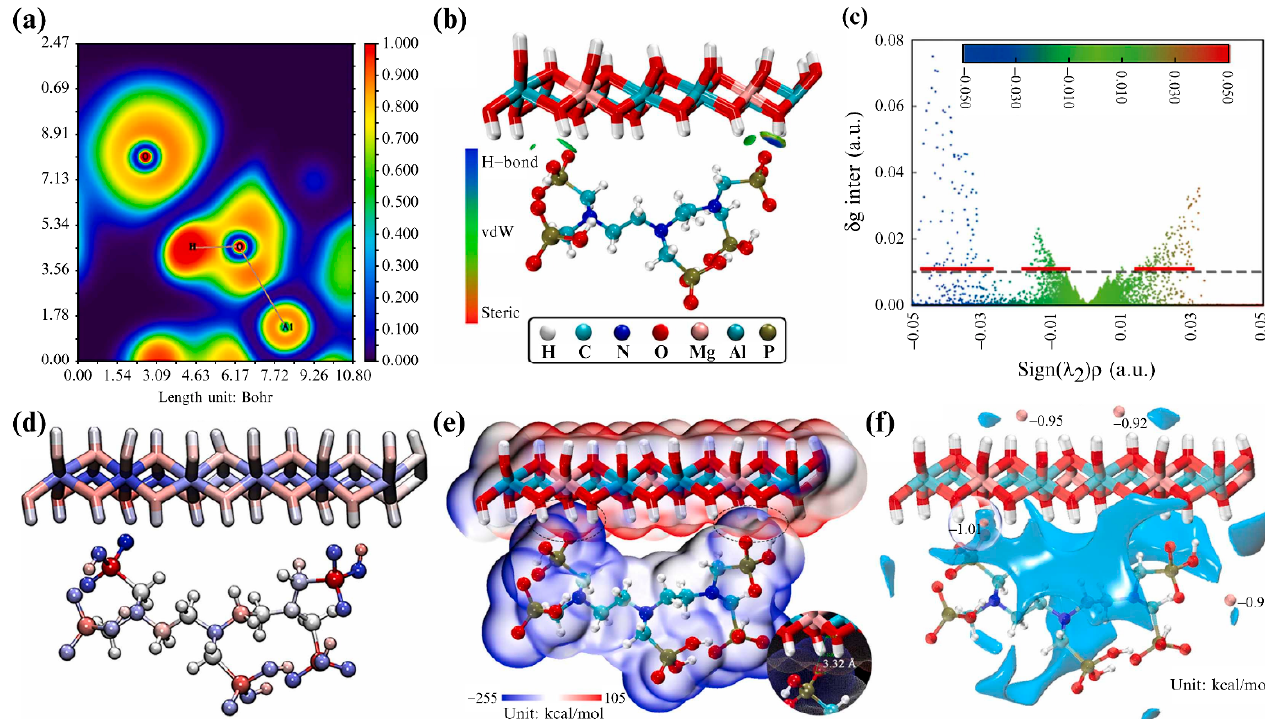
Figure 1. ( a ) Color-filled electron localization function diagram. ( b ) Optimized structure and independent gradient model based on a Hirshfeld partition (IGMH) map (isovalue = 0.01 a.u.). ( c ) Sign( λ 2 ) ρ —colored IGMH scatter plot. ( d ) Colored atoms based on their contribution to the interaction energy. ( e ) Electrostatic potential mapping on the van der Waals surface. ( f ) Isosurface map of the van der Waals potential using C as the probe atom. Reproduced with permission from [14].